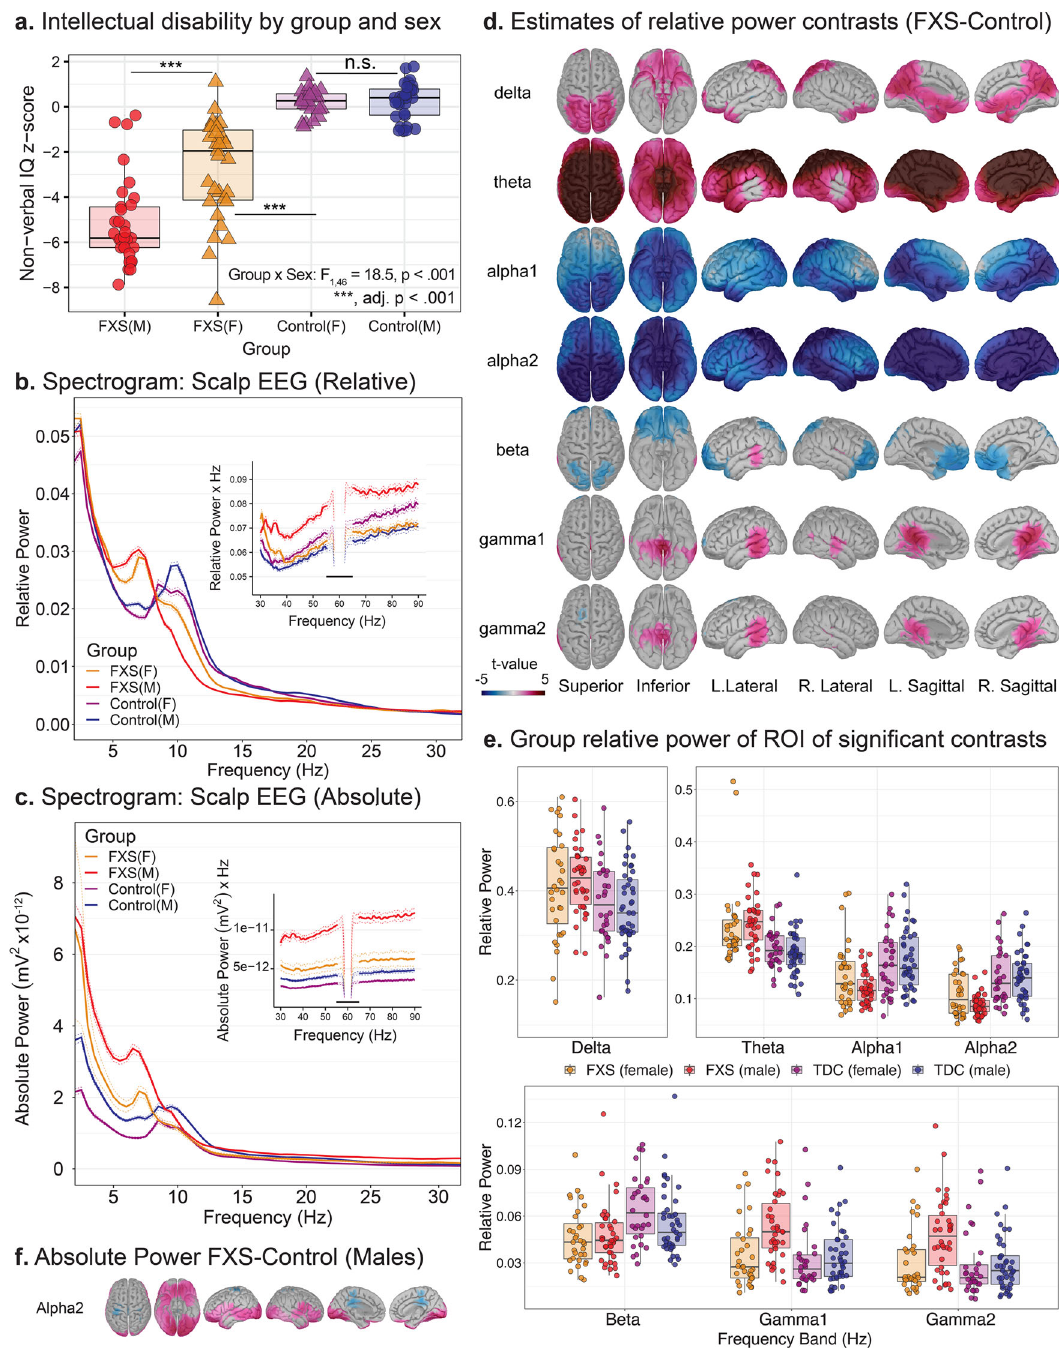
restricted to the bilateral temporal lobes and regions of the par- ietal and occipital lobes. We again con fi rmed that the decrease in alpha2 was not due to relative power normalization by comparing source-localized absolute power between groups. Even consider- ing that mean absolute power was increased across all frequency bands in FXS, at the group level, alpha1 and alpha2 activity were higher only in lateral regions in FXS (Supplementary Fig. 2). In a subgroup of males with FXS, absolute alpha2 power had sig- ni fi cant clusters of increased and decreased alpha2 absolute power compared to control males (Fig. 2f). We examined addi- tional sex effects at the region and network-level based on these signi fi cant group